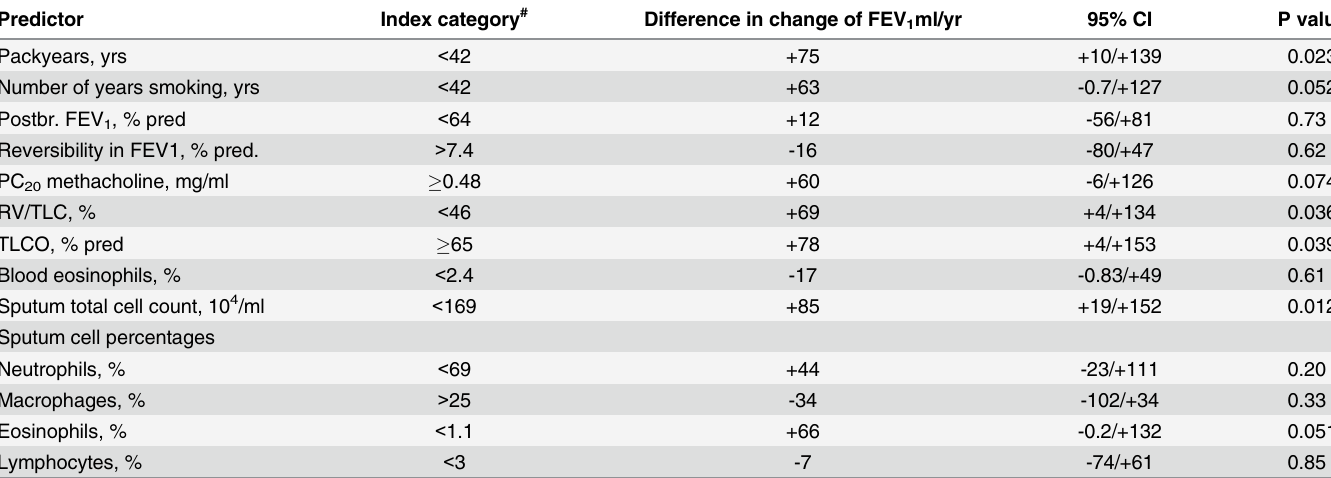
Table 4. Predictors of attenuation of long-term FEV 1 decline by fluticasone treatment.